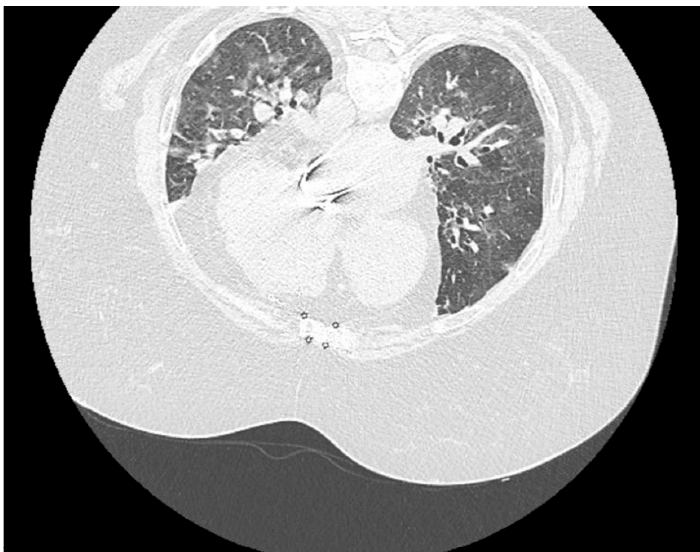
Figure 3. Native thoraco-pulmonary CT of the patient, revealing a viral SARS-CoV-2 pneumonia with a degree of damage around 50–60% and with unsystematized central and peripheral pulmonary infiltrates and ground-glass opacities.